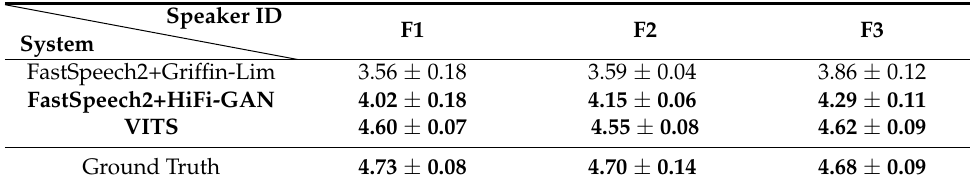
Table 2. Naturalness mean opinion score (N-MOS) results for all systems with 95% confidence intervals.